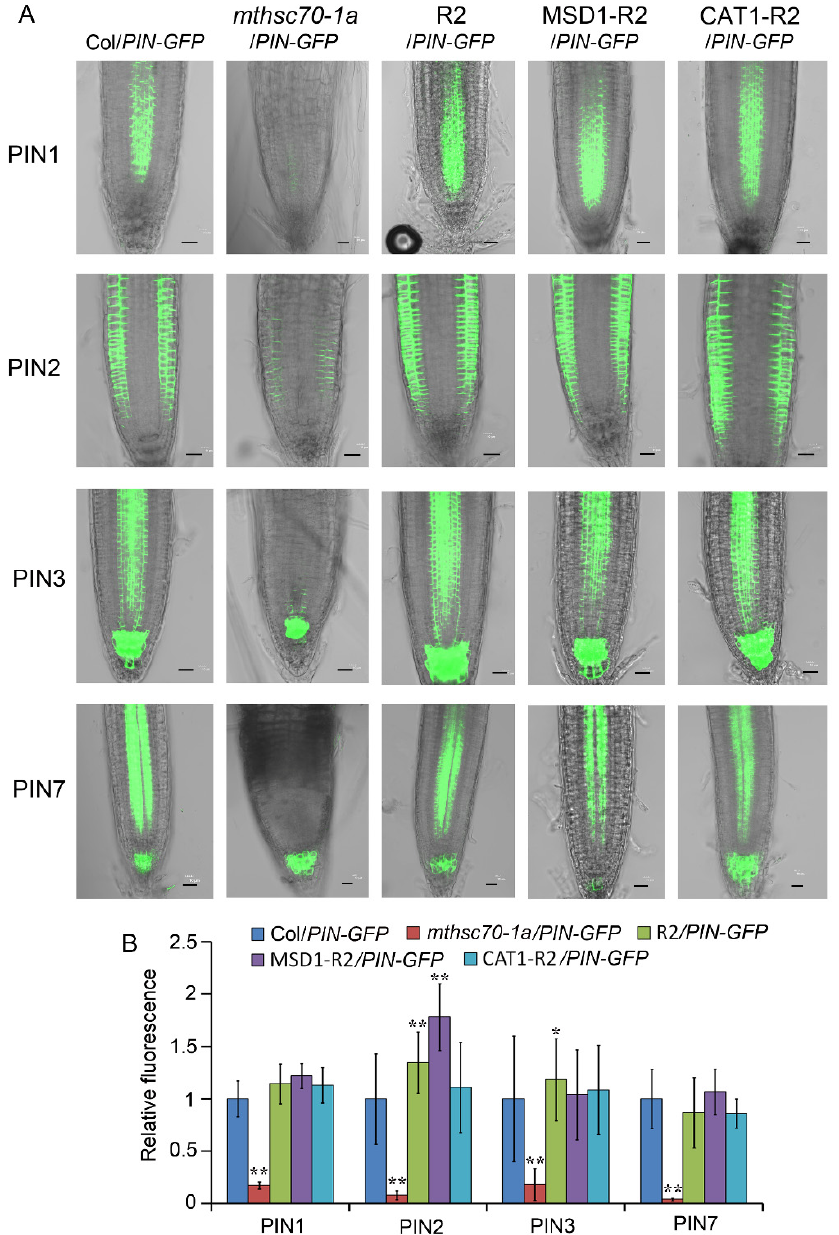
Figure 9. Introduction of the mtHSC70-1 , MSD1 or CAT1 gene into mthsc70-1a / PIN-GFP plants rescued the levels of PIN proteins in root tips. ( A ) The roots of 5 days old seedlings with different genotypes were observed using a LSCM; representative images are shown. Scale bar = 20 µ m. ( B ) The GFP fluorescence intensities were visualized with ImageJ 1.42q software (National Institutes of Health, Bethesda, MD, USA). The asterisks indicate significant differences from the Col/ PIN-GFP plants ( t- test, *, p < 0.05; **, p < 0.01). Col/ PIN-GFP , Col/ PIN1- , 2- , 3- or 7-GFP plants; mthsc70-1a / PIN-GFP , mthsc70-1a / PIN1- , 2- , 3- or 7-GFP plants; R2/ PIN-GFP , R2/ PIN1- , 2- , 3- or 7-GFP plants; MSD1-R2/ PIN-GFP , MSD1-R2/ PIN1- , 2- , 3- or 7-GFP plants; CAT1-R2/ PIN-GFP , CAT1-R2/ PIN1- , 2- , 3- or 7-GFP plants .